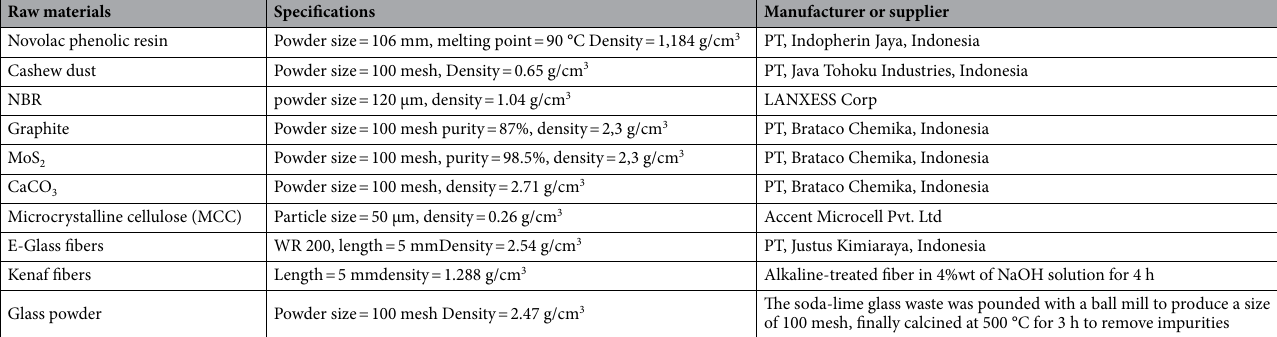
Table 2. List of raw materials and manufacturers.